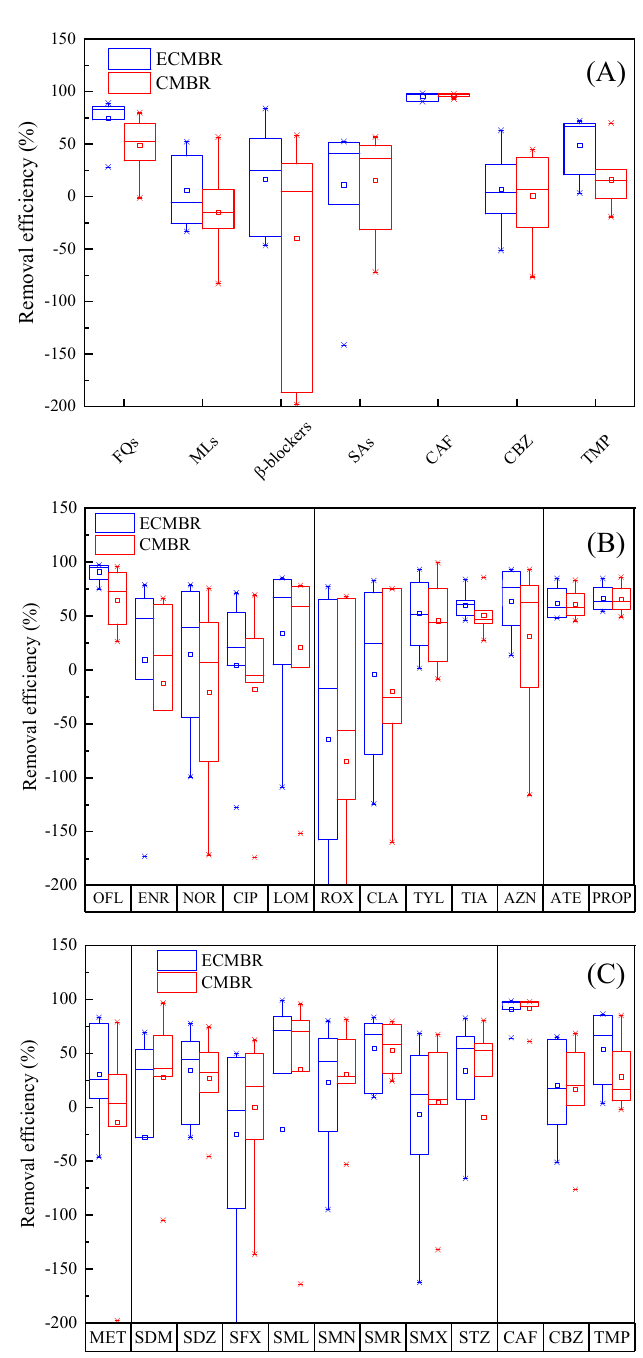
Figure 4. ( A ) Removal efficiencies of 7 groups of pharmaceutical and personal care products (PPCPs) in the ECMBR and CMBR. In each group, the sum of all the PPCP concentrations is regarded as the concentration of the group. Removal efficiencies of target PPCPs in the ECMBR and CMBR: ( B ) fluoroquinolones (FQs), MLs, and b-blockers; ( C ) SAs, CAF, CBZ, and TMP.